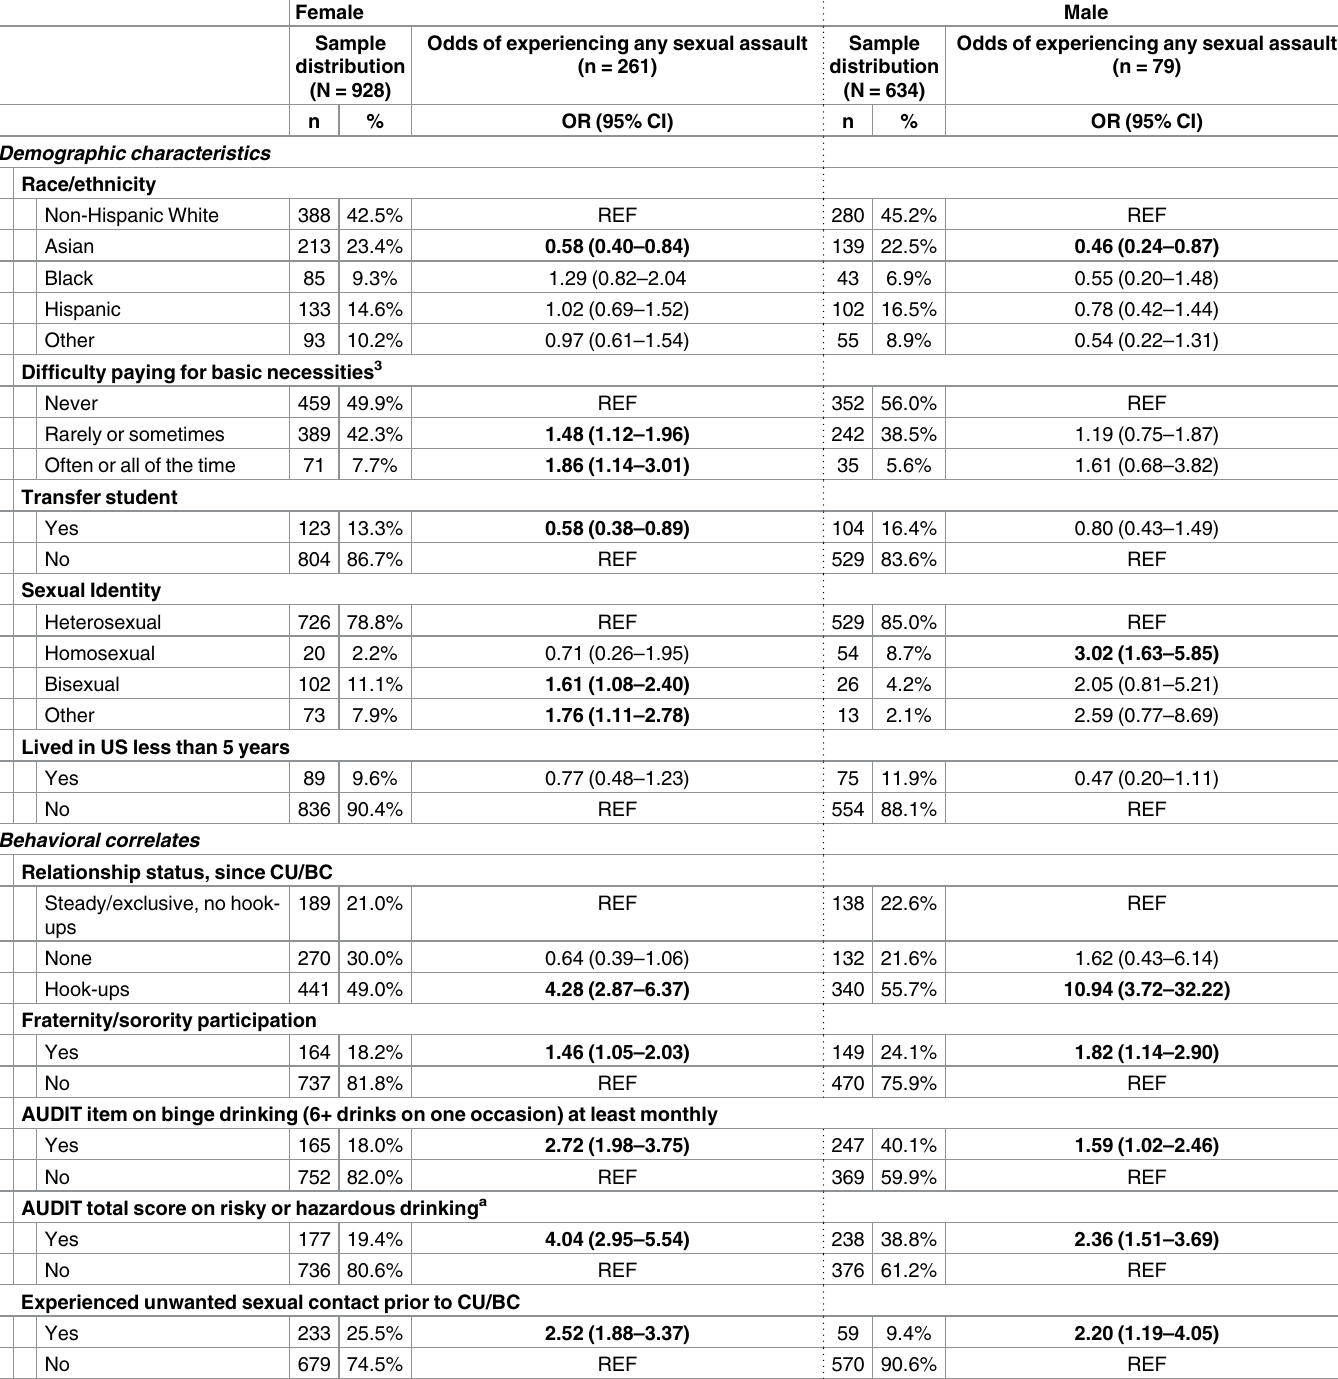
Table 4. Associations between demographic and behavioral characteristics and experienceof any sexual assault since enrolling at CU/BC, by